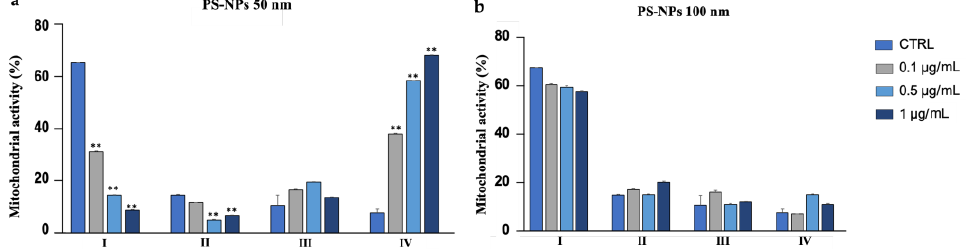
Figure 12. ( a ) Mean percentage of mitochondrial activity of spermatozoa after exposure (30 min) to 50 nm PS-NPs at increasing concentrations. Strong statistically differences (** p < 0.01) have been found between samples and control groups; ( b ) Mean percentage of mitochondrial activity of sper- matozoa after exposure (30 min) to 100 nm PS-NPs at increasing concentrations. Approximately 400 spermatozoa were counted in five different fields for each sample. In addition, two replicates were performed, in a total of 8 samples and 3200 spermatozoa analyzed. No statistical differences have been found between samples and control groups. 4. Discussion Nanoplastics pollution has generated growing apprehension in the academic com- munity, especially because the most recent and alarming findings have corroborated the ability of nanoplastics to penetrate the human body and be absorbed and biodistributed through the bloodstream to bioaccumulate in different organ. Because several studies on mouse models have confirmed the sensibility of the testis to the influence of nanoplastics, proposing and translating this result also for other mammals, including humans, in the